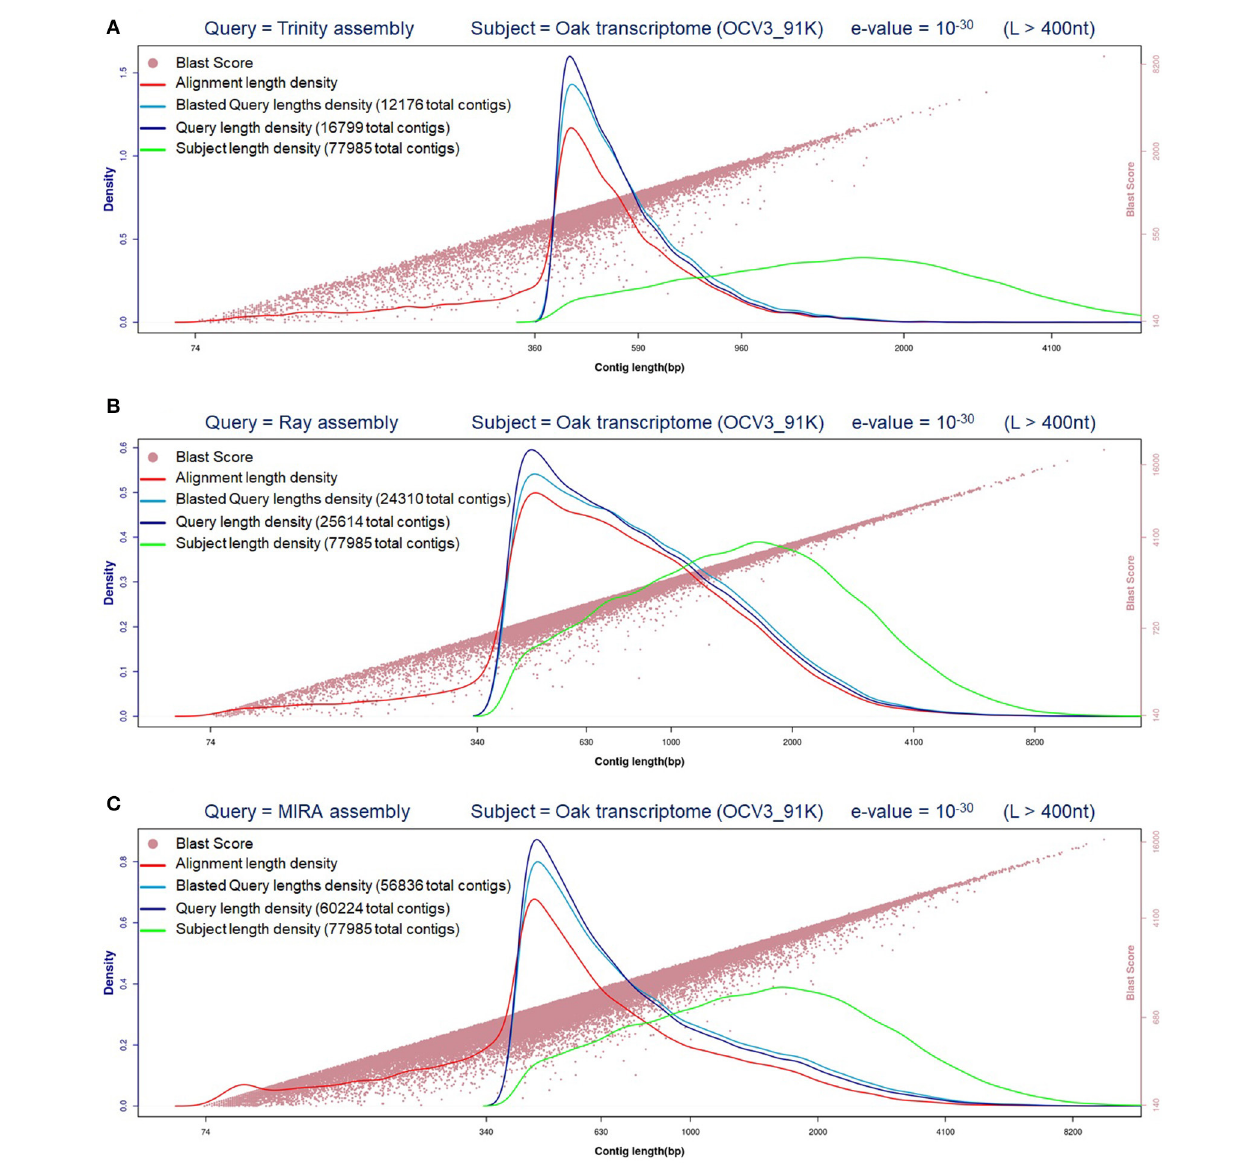
FIGURE 1 | Evaluation of Q.ilex transcriptomes generated. Contig (longer than 400 nucleotides = L > 400 nt) length distribution and comparative evaluation against oak transcriptome (BlastN e-value = 10 − 30 ). (A) Trinity; (B) Ray; (C)